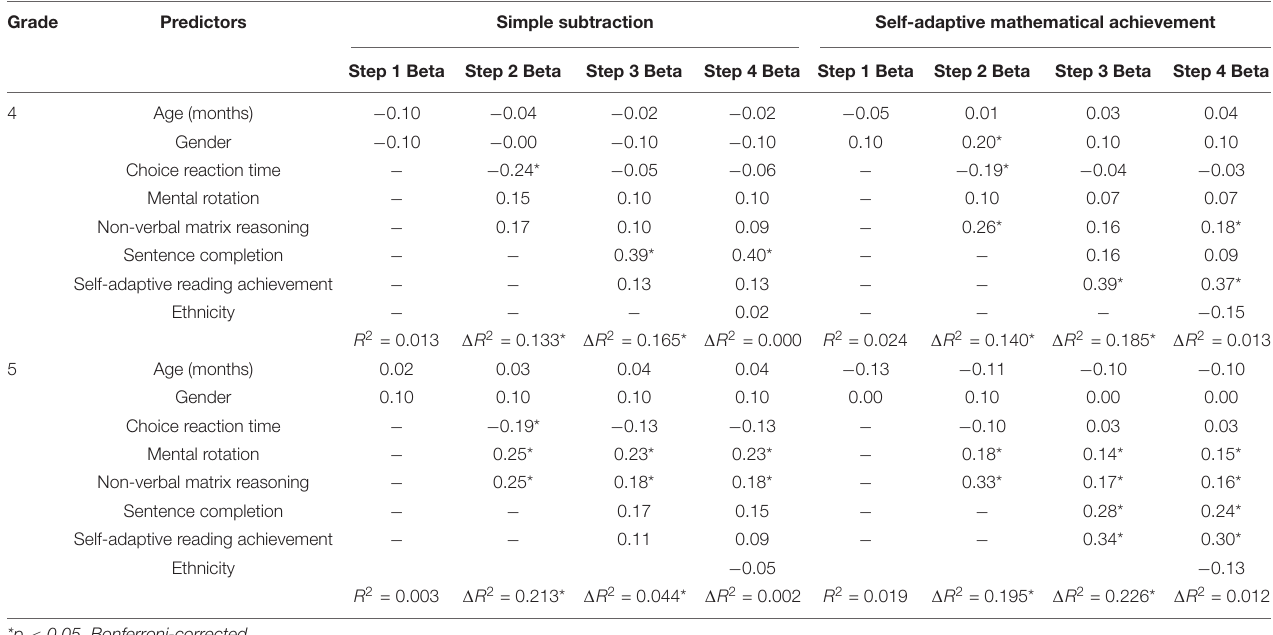
TABLE 5 | Hierarchical regression models predicting simple subtraction and self-adaptive mathematical achievement from age, gender, general cognitive processing, sentence completion, self-adaptive reading achievement, and ethnicity. Grade Predictors